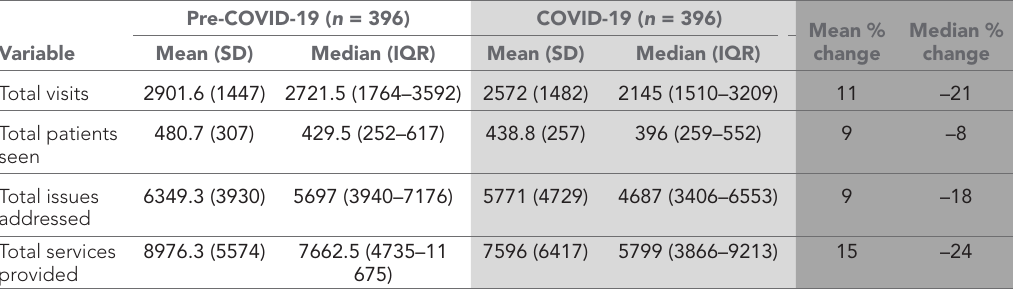
Table 2 Median and mean numbers of visits, patients, issues addressed, and services provided